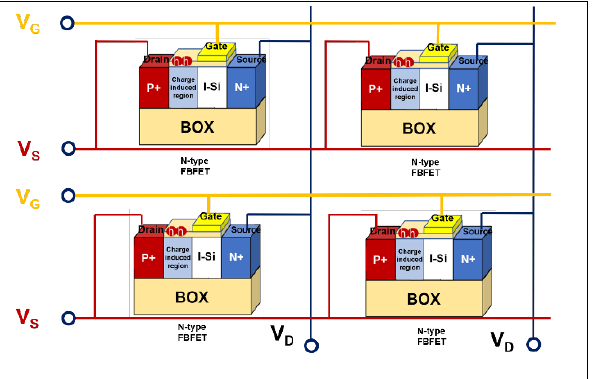
Figure 9. Illustration of a capacitorless dynamic random-access memory (DRAM) circuit composed of an FBFET [43,44].